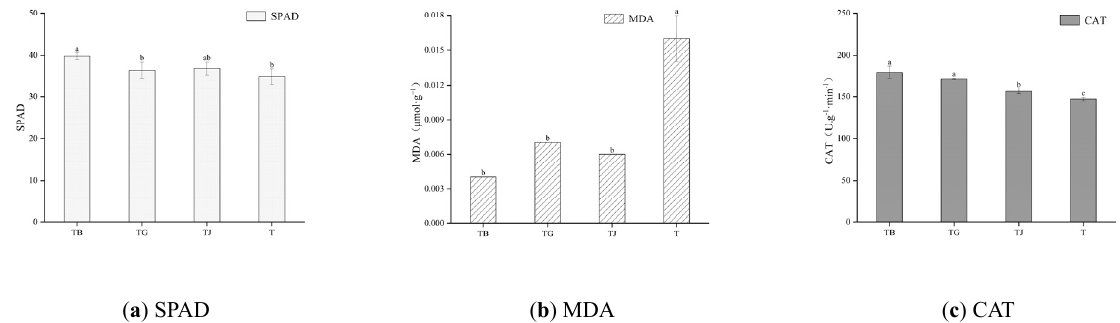
Figure 2. Changes in physiological indexes of Bra. under different treatments. Note: TB: Brassica parachinensis-Trifolium repens; TG: Brassica parachinensis-Festuca arundinacea; TJ: Brassica parachinensis-Ageratum conyzoides L.; T: Brassica parachinensi; MDA: Malonaldehyde; CAT: Catalase. Different letters in the same column in the figure indicate that the difference between different treatments is significant ( p < 0.05). The data in the table are the mean ± standard deviation of 3 repetitions.